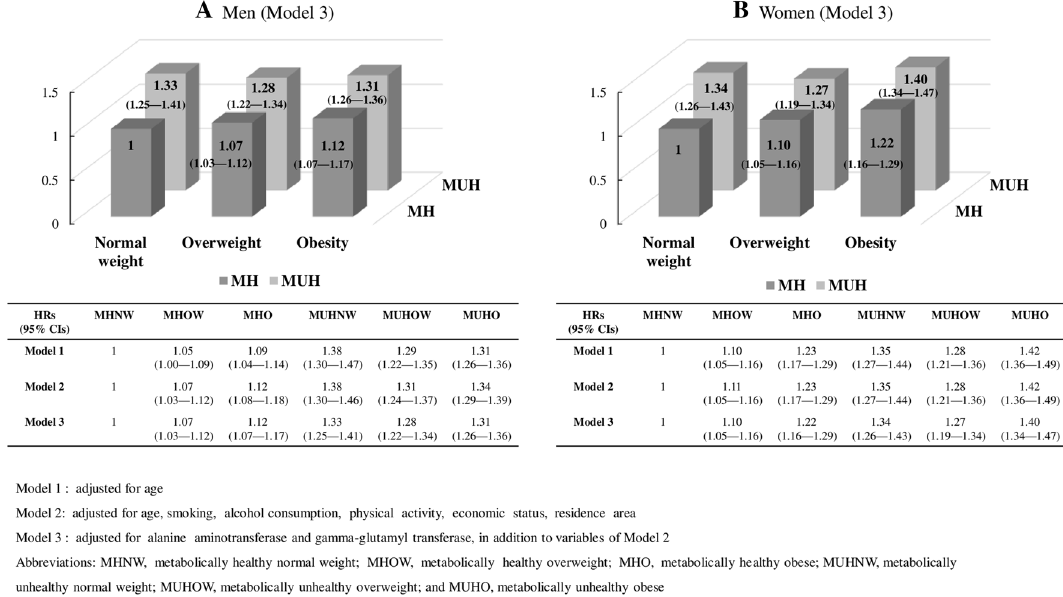
Figure 3. Cox proportional hazards regression models for composite outcome (all-cause mortality and incidence of cardiovascular